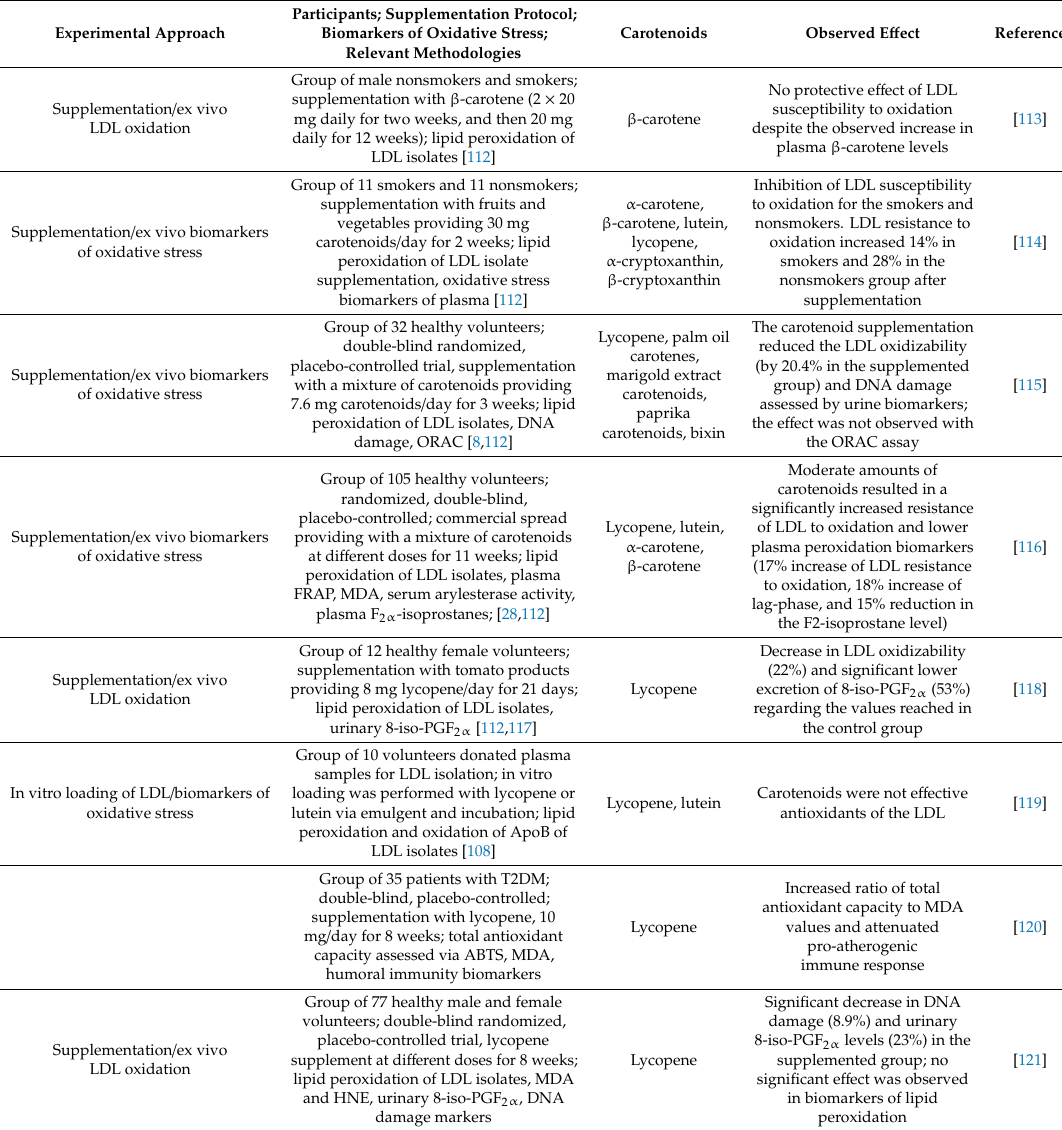
Table 4. Relevant studies dealing with the ex vivo antioxidant capacity of carotenoids in LDLs. Participants; Supplementation Protocol; Experimental Approach Biomarkers of Oxidative Stress; Carotenoids Observed E ff ect Relevant Methodologies